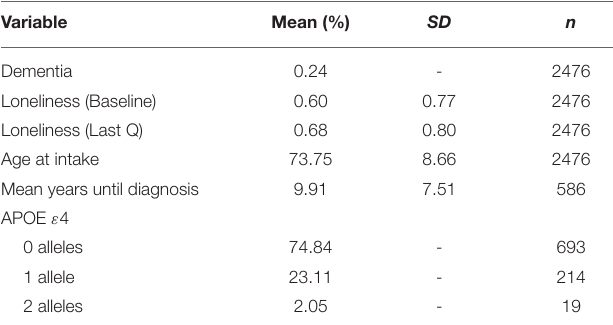
TABLE 1 | Descriptive statistics of GOS sample.